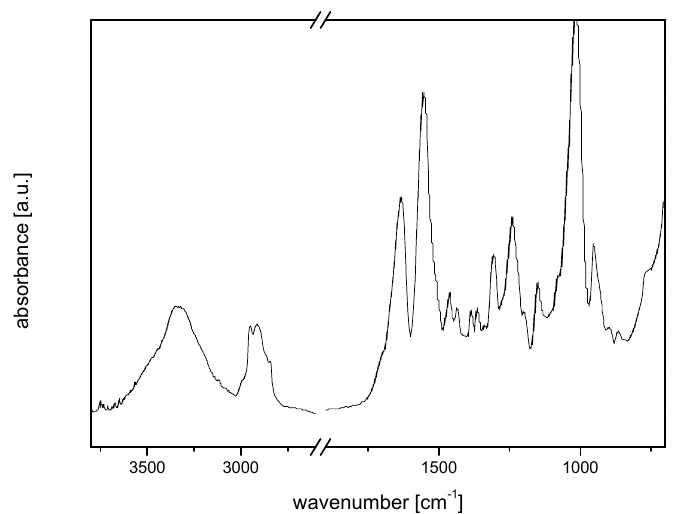
Figure 1. Fourier transform infrared (FT-IR) spectrum of isophorone diisocyanate (IPDI) based polyurethanes (PU) (75% IPDI/25% ethyl ester L -lysine triisocyanate (LLTI)).